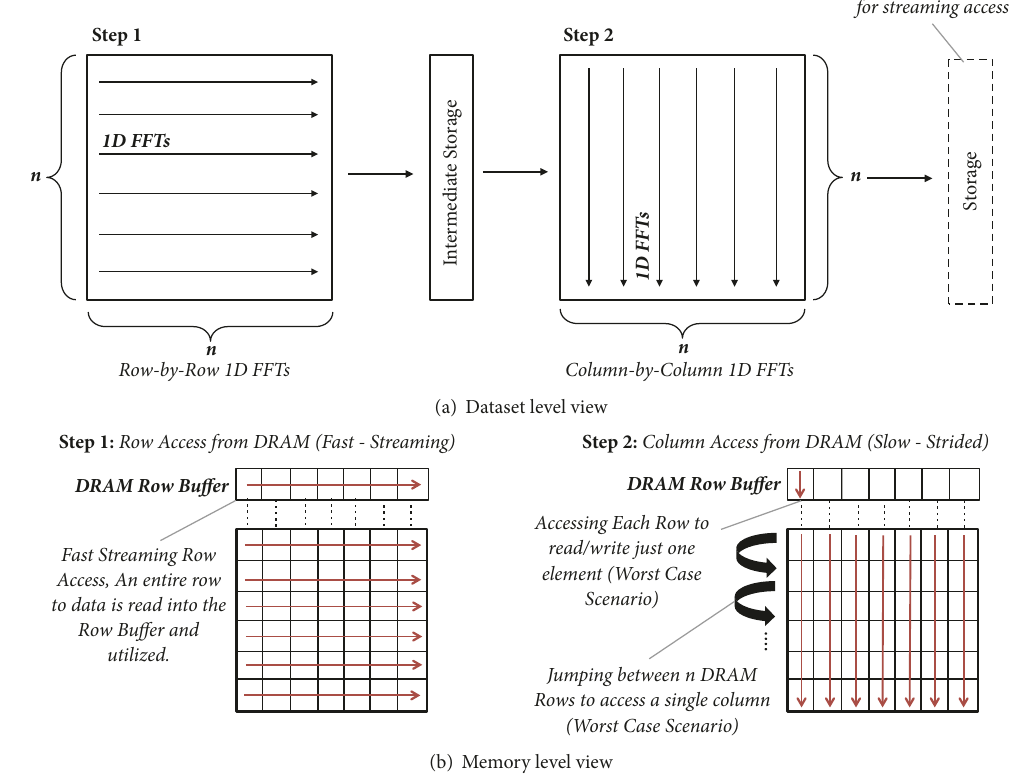
Figure 1: (a) An overview of row-column decomposition (RCD) for 2D FFT implementation. Intermediate storage is required because all elements of the row-by-row operations must be available for column-by-column processing. (b) An overview of strided column-wise access from DRAM as compared to trivial row-wise access. An entire row of elements must be read into the row buffer even to access a single element within a specific